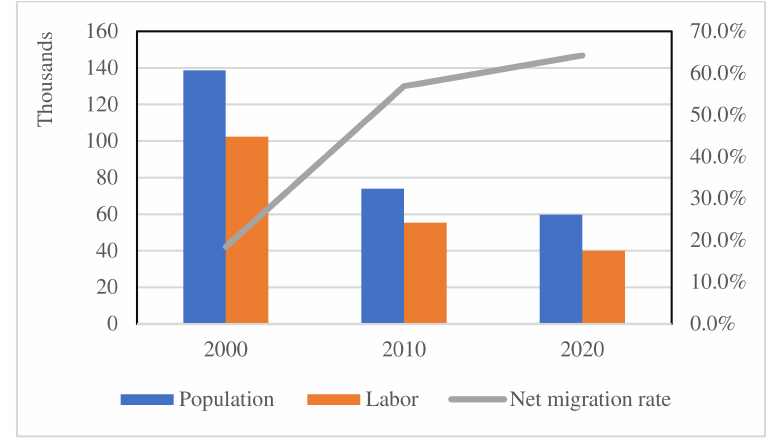
Figure 3. Rural population change in Taibus from 2000 to 2020.